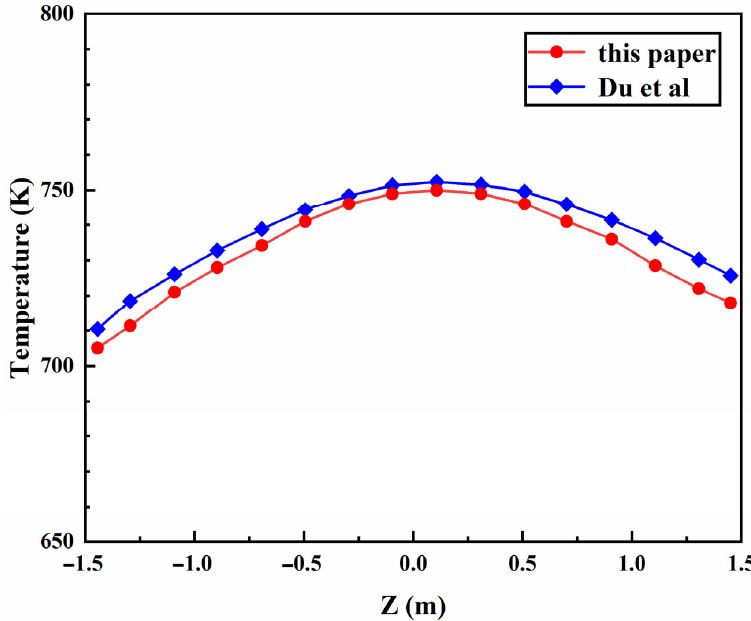
Figure 6. Temperature analysis results of this paper and those indicated by Du et al. [2].